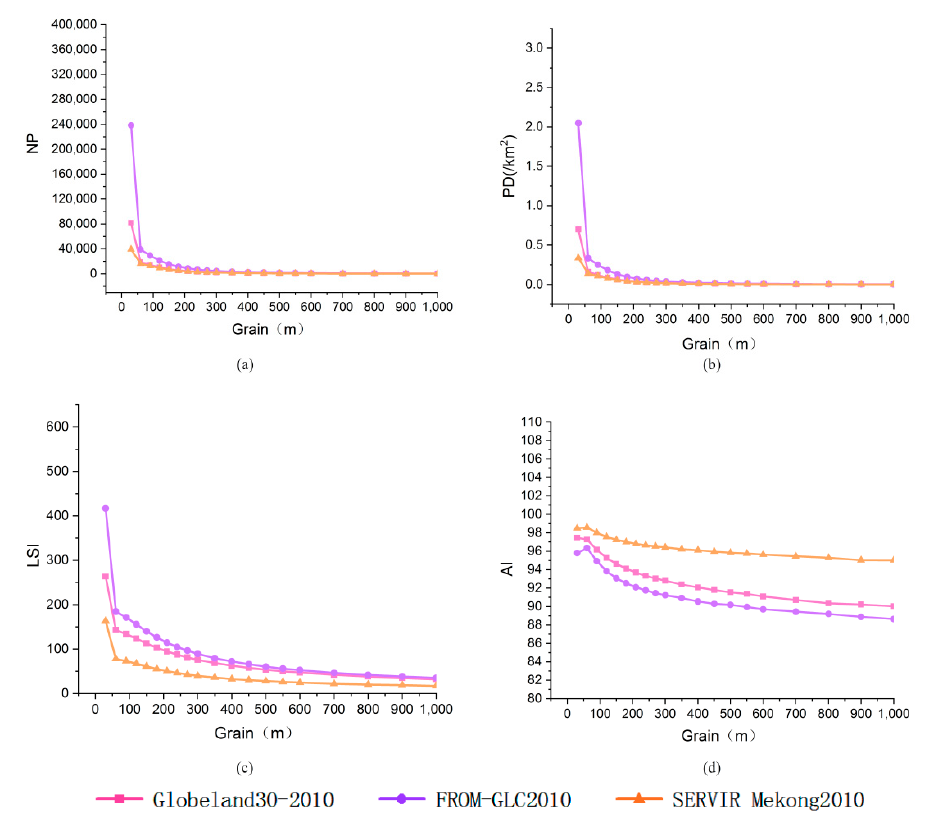
Figure 5. The forest landscape pattern indices changing curves with scale increasing. ( a ) is the NP curve; ( b ) is the PD curve; ( c ) is the LSI curve; ( d ) is the AI curve.